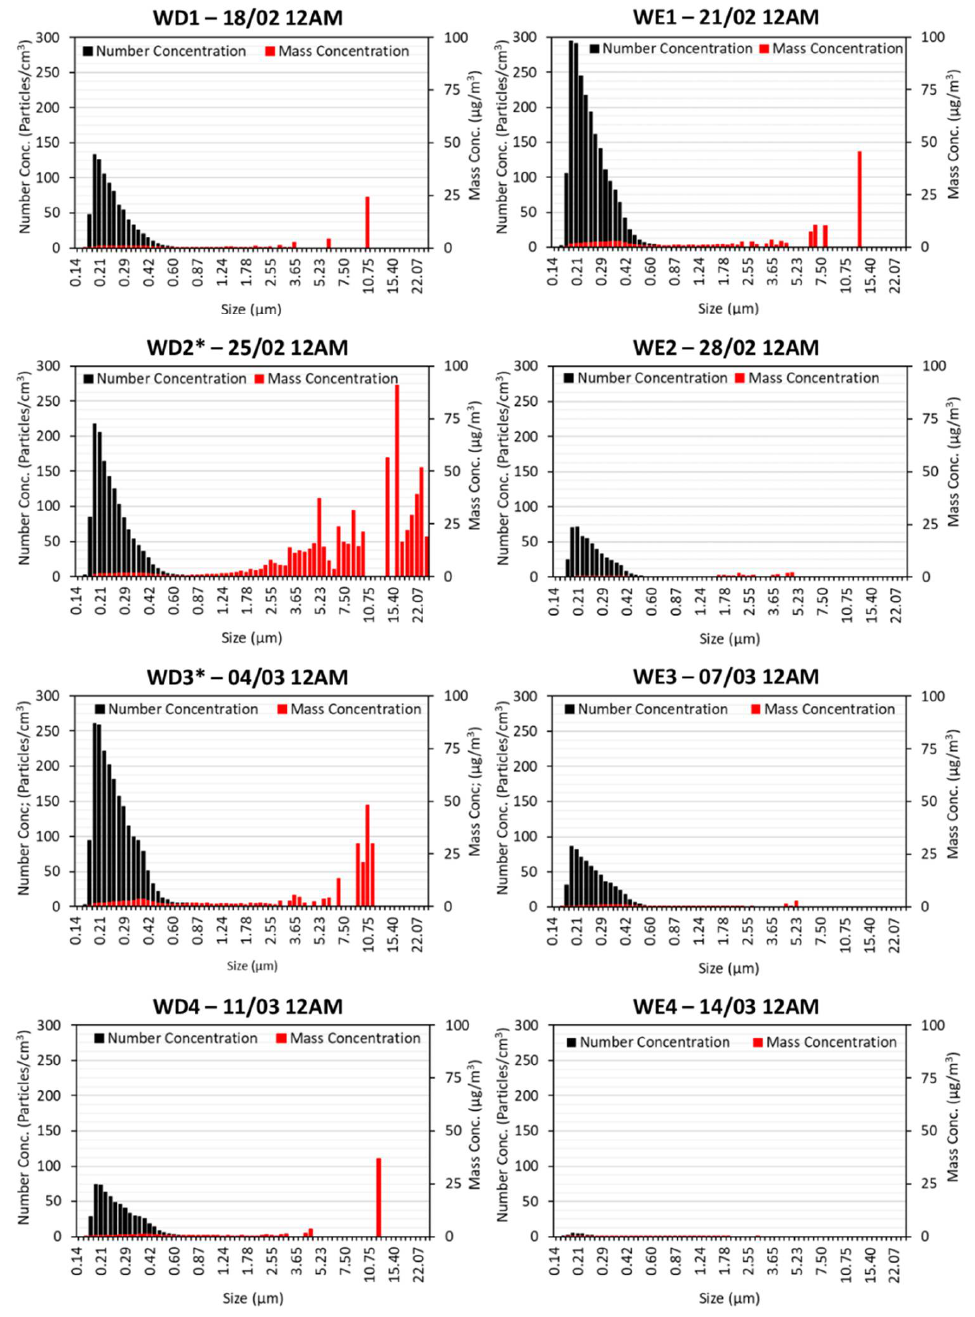
Figure 3. Particle size distribution by number and by mass, obtained with the particle analyser, for the different sampling periods: WD ( left ) and WE ( right ), extracted at 12 AM of the indicated date. (* used to indicate the sampling periods when the pollution episodes occurred.).